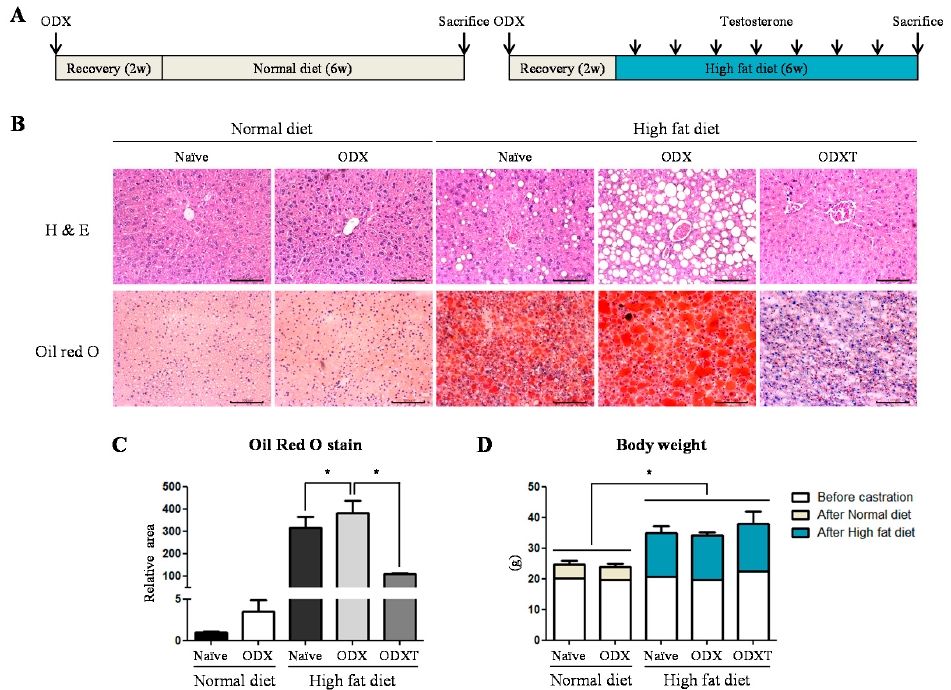
Figure 1. Depending on high energy diet and androgen, the lipid accumulation level within the liver fluctuates in male mice. ( A ) A schematic diagram shows the schedule of an animal experiment. After surgical castration (ODX) to deprive male mice of endogenous androgen, the mice were fed with a high-fat diet (HD) and injected with testosterone (T) for 6 weeks. ( B ) Their livers were used to hematoxylin and eosin stain (H&E) and Oil-Red O stain, to examine the degree of accumulated lipid. Scale bar = 100 µm. ( C ) In the Oil-Red O stain, the areas of lipid droplets were quantified by image J program. ( D ) To consider whether hepatic TG accumulation influences bodyweight, the weight was measured. The values stand for means +/ − S.D. * p < 0.05 was compared to groups indicated. Representing the induction of fibrotic responses in the liver [17], TGF- β mRNA levels increased in HD-ODX mice, as compared to HD-Naïve mice (2.08 fold, p < 0.05) and HD-ODXT mice (1.89 fold, p < 0.05) (Figure 2C). When we performed Masson’s trichrome staining to detect fibrotic areas, the level of fibrosis was significantly higher in the HF-ODX group than in the HD-Naïve (1.52 fold, p < 0.05) and HD-ODXT (3.00 fold, p < 0.05) groups, similar to the TGF- β mRNA levels (Figure 2D). These results indicate that androgens may induce the development of NAFLD and facilitate the progression of NAFLD to NASH or cirrhosis.